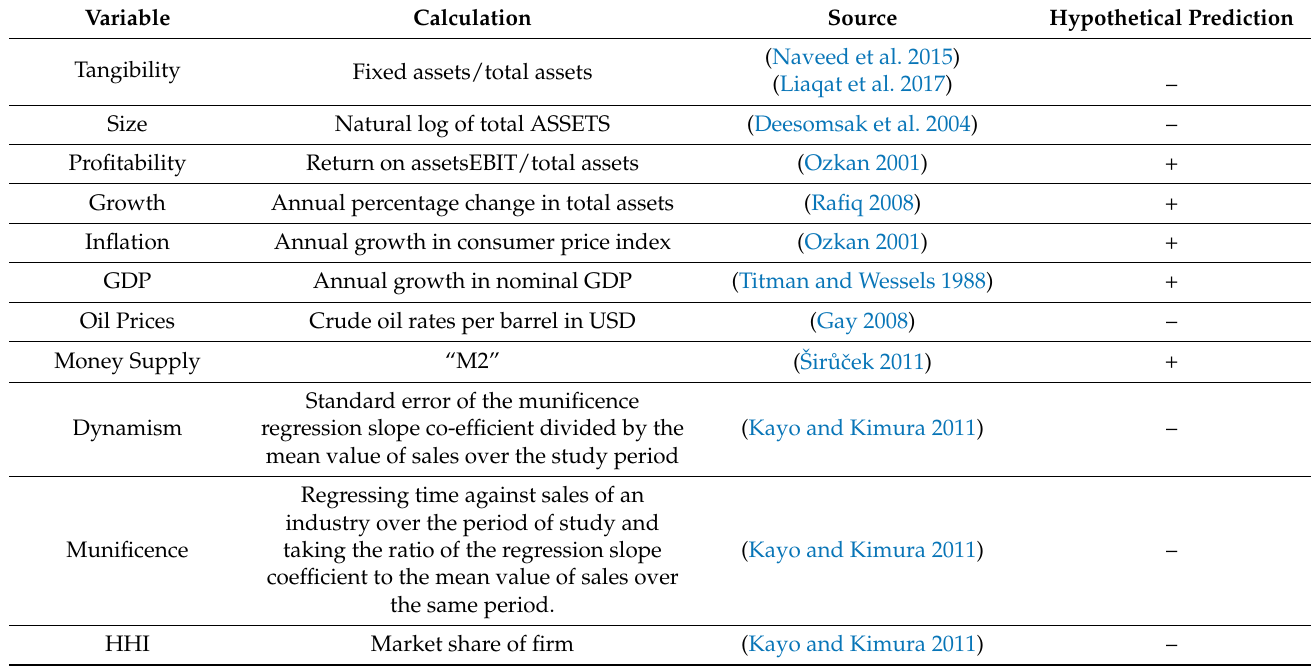
Table 1. Formulation of